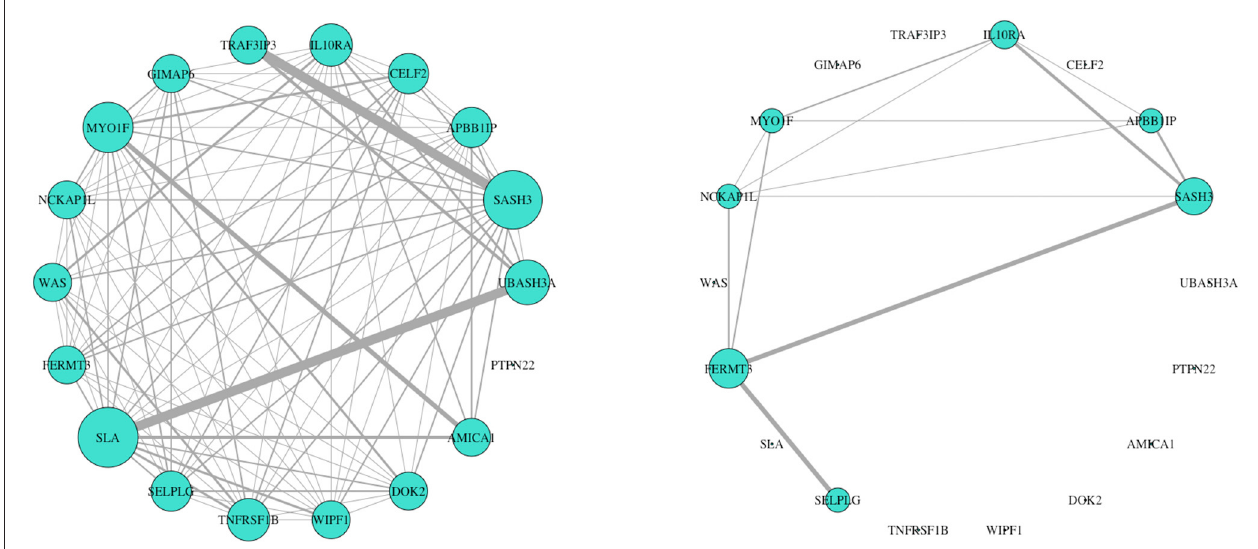
FIGURE 5 | Network structure of 18 DW hub genes showed striking expression connectivity measure differences between HNSCC progressor (left) and non-progressor (right) conditions. These genes were identified as differentially wired hub nodes in the turquoise module [kME > 0.8 and enriched in changed edges ( p < 0.01; Binomial)]. Visually, wiring width demonstrates correlation magnitude strength. Weights are correlations > 0.6 to capture mid/low strength connectivity in the non-progressor condition. The size of each gene’s node indicates overall connectivity